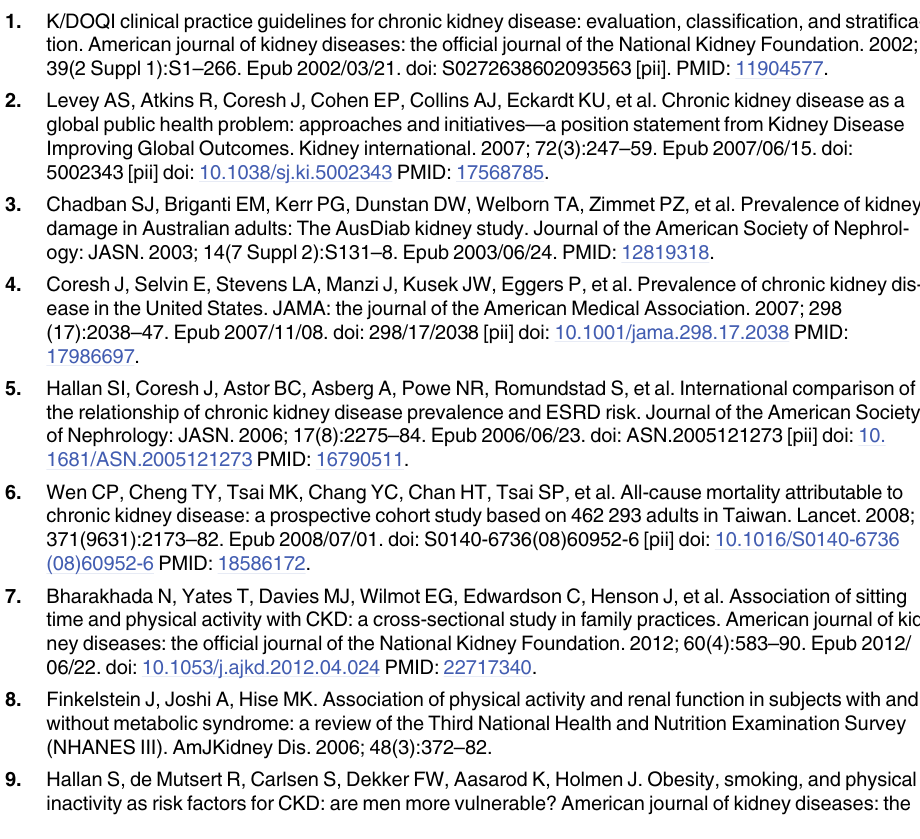
S1 Table. Regression coefficients (mL/min per 1.73 m 2 ) and 95% confidence intervals for the association between physical activity and creatinine-based estimated glomerular filtra- tion rate at the subsequent round, adjusted for time-varying covariates. S2 Table. Regression coefficients (mL/min per 1.73 m 2 ) and 95% confidence intervals for the associations between 5-year changes in physical activity and creatinine-based estimated glomerular filtration rate at the subsequent round, adjusted for attained time-varying